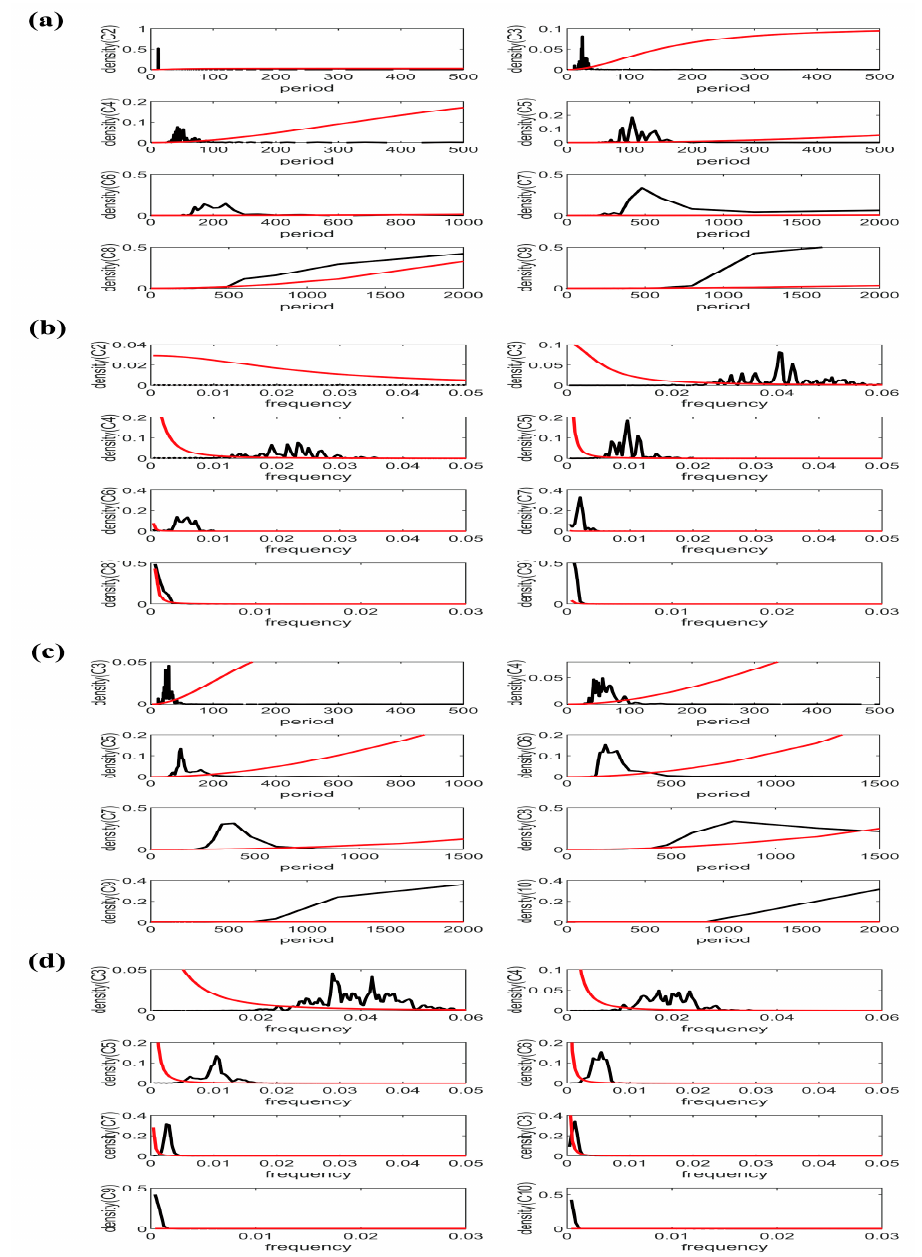
Figure 3. Power spectrum analysis of IMFs at Hong Kong in GBA (period-density ( a ), frequency- density ( b )) and Stockholm in BSA (period-density ( c ), frequency-density ( d )).